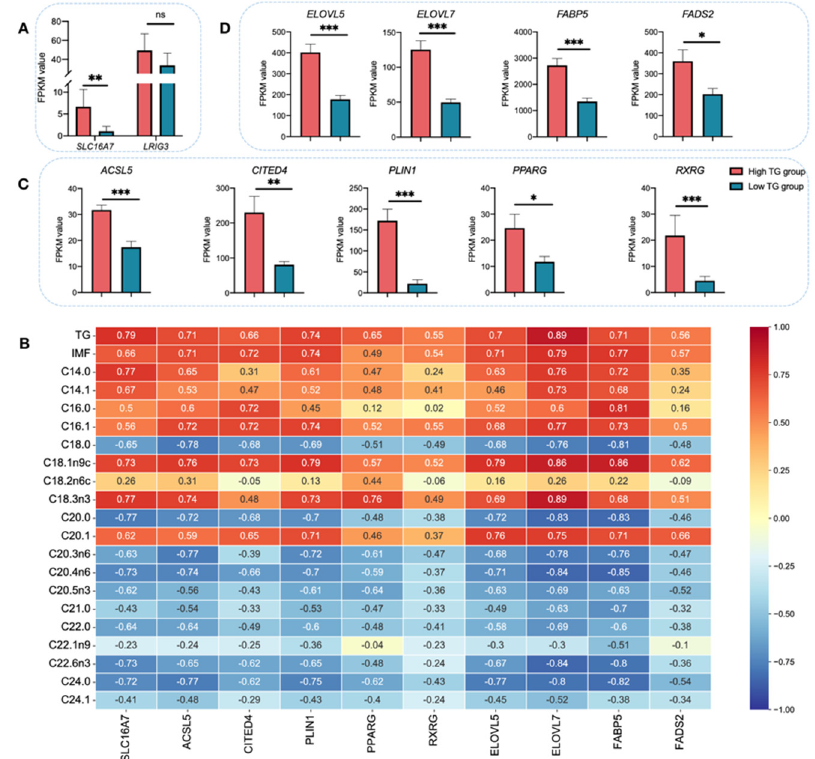
Figure 3. Association of SLC16A7 with the TG and poly fatty acid contents. ( A ) The expression of genes related to SLC16A7 and LRIG3 (** p < 0.01). ( B ) Relationship between lipid metabolism- related genes and TG, IMF and fatty acid traits in breast muscle tissue (MEbisque4 module). ( C ) The expression of genes related to TG esterification and adipocyte differentiation (* p < 0.05, ** p < 0.01, *** p < 0.001). ( D ) The expression of genes related to FA metabolism. (* p < 0.05, *** p <